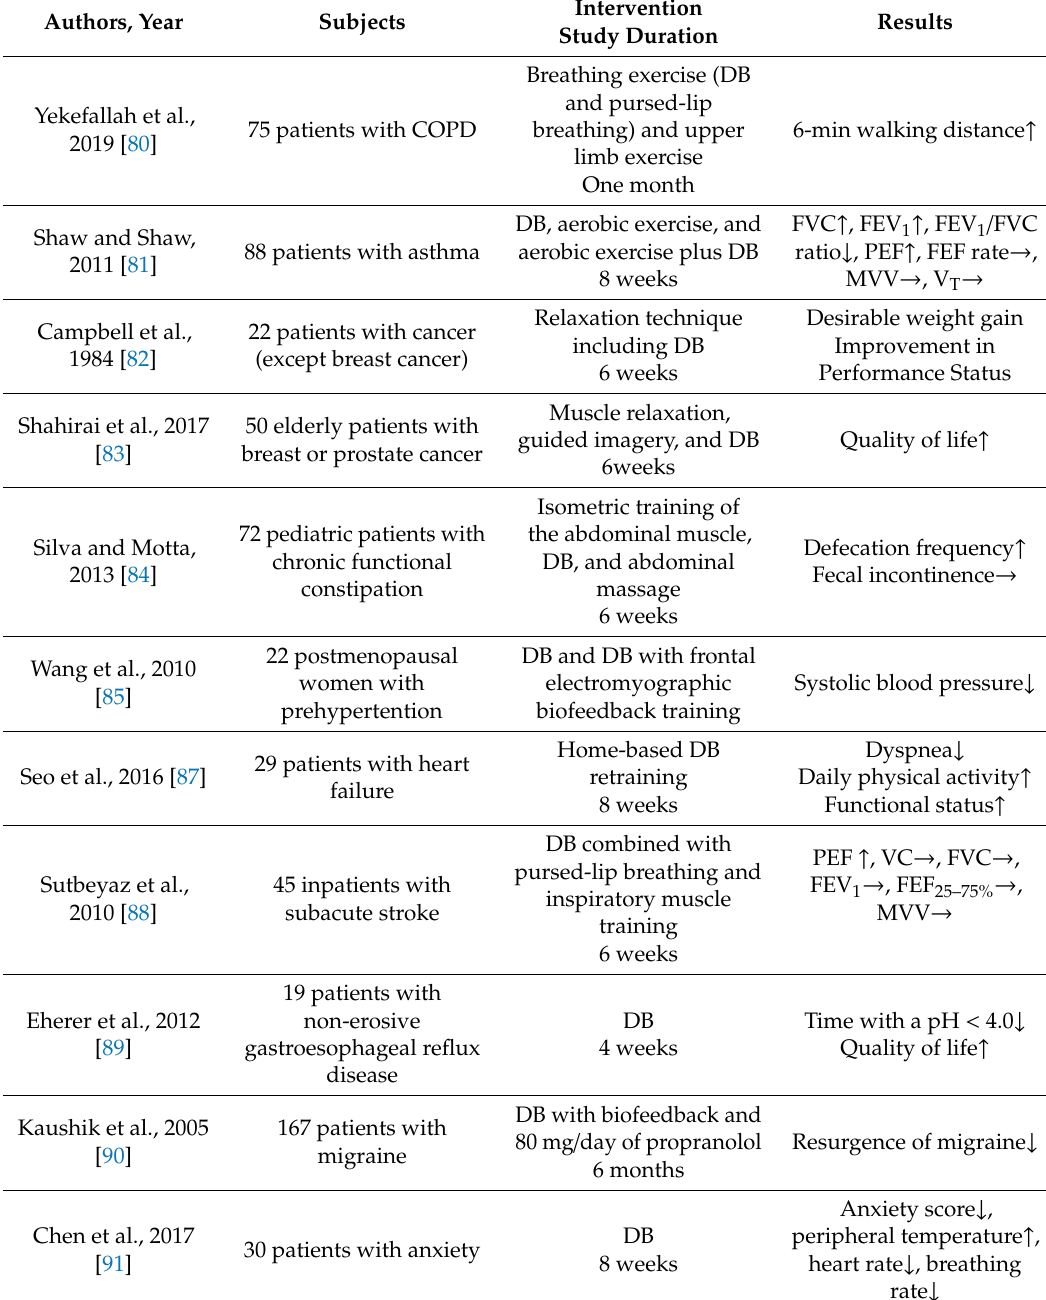
Table 2. Randomized controlled trials assessing the e ff ects of diaphragmatic breathing on various